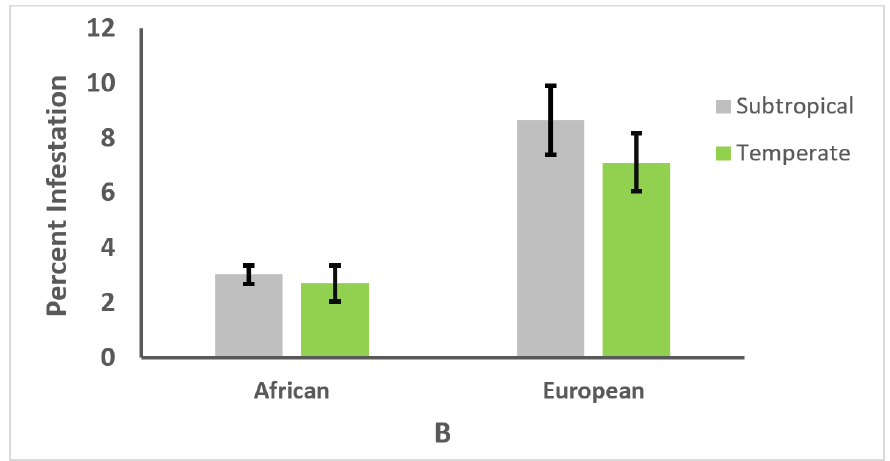
Figure 3. Percentage ( ± SE) of comb cells containing honey bee brood ( A ) or adult bees ( B ) of African or European genotype (with the same morphotype and mitotype, respectively) that were infested with Varroa destructor in 273 colonies located in subtropical and temperate climates.